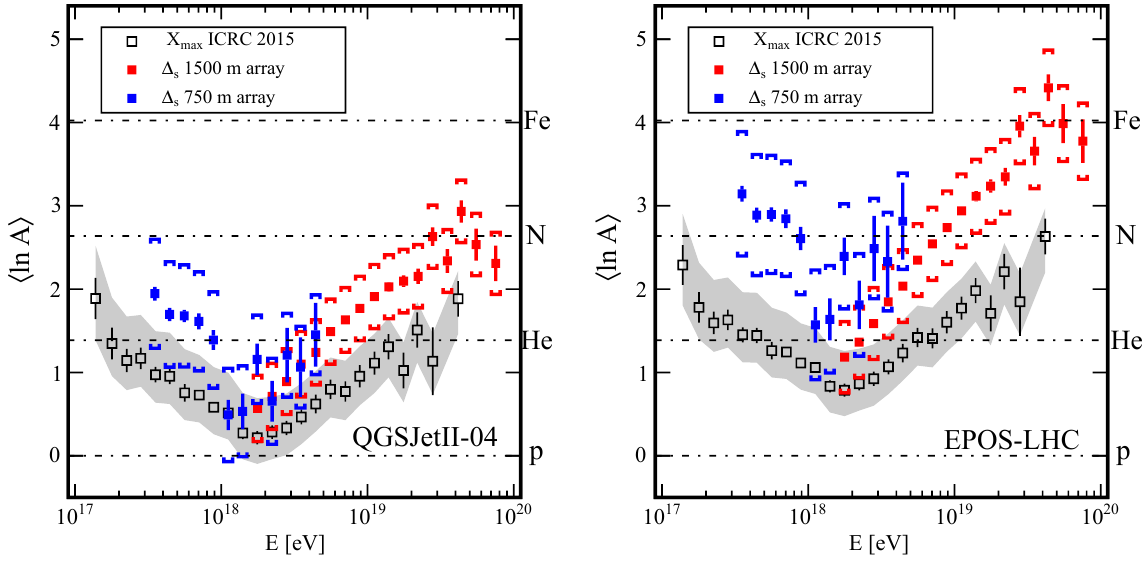
Figure 12. (cid:104) lnA (cid:105) as a function of energy for the Delta method and for X max measurements done with the FD. QGSJetII-04 and EPOS- LHC have been used as the reference hadronic models. Statistical uncertainties are shown as bars. Brackets and shaded areas correspond to the systematic uncertainties associated to the measurements done with the SD and FD data,